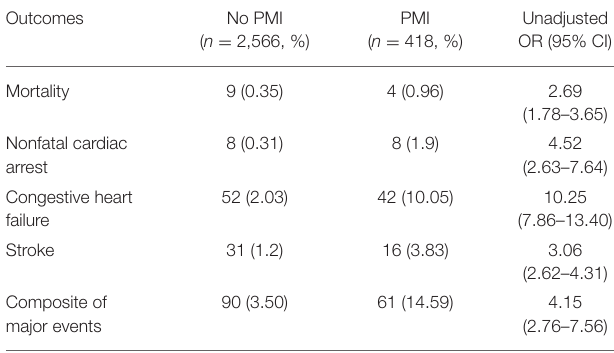
TABLE 4 | Thirty-day